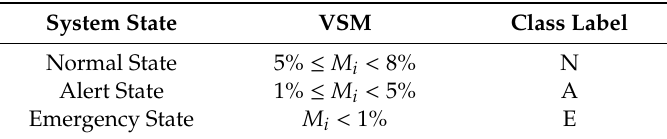
Table 1. Voltage stability